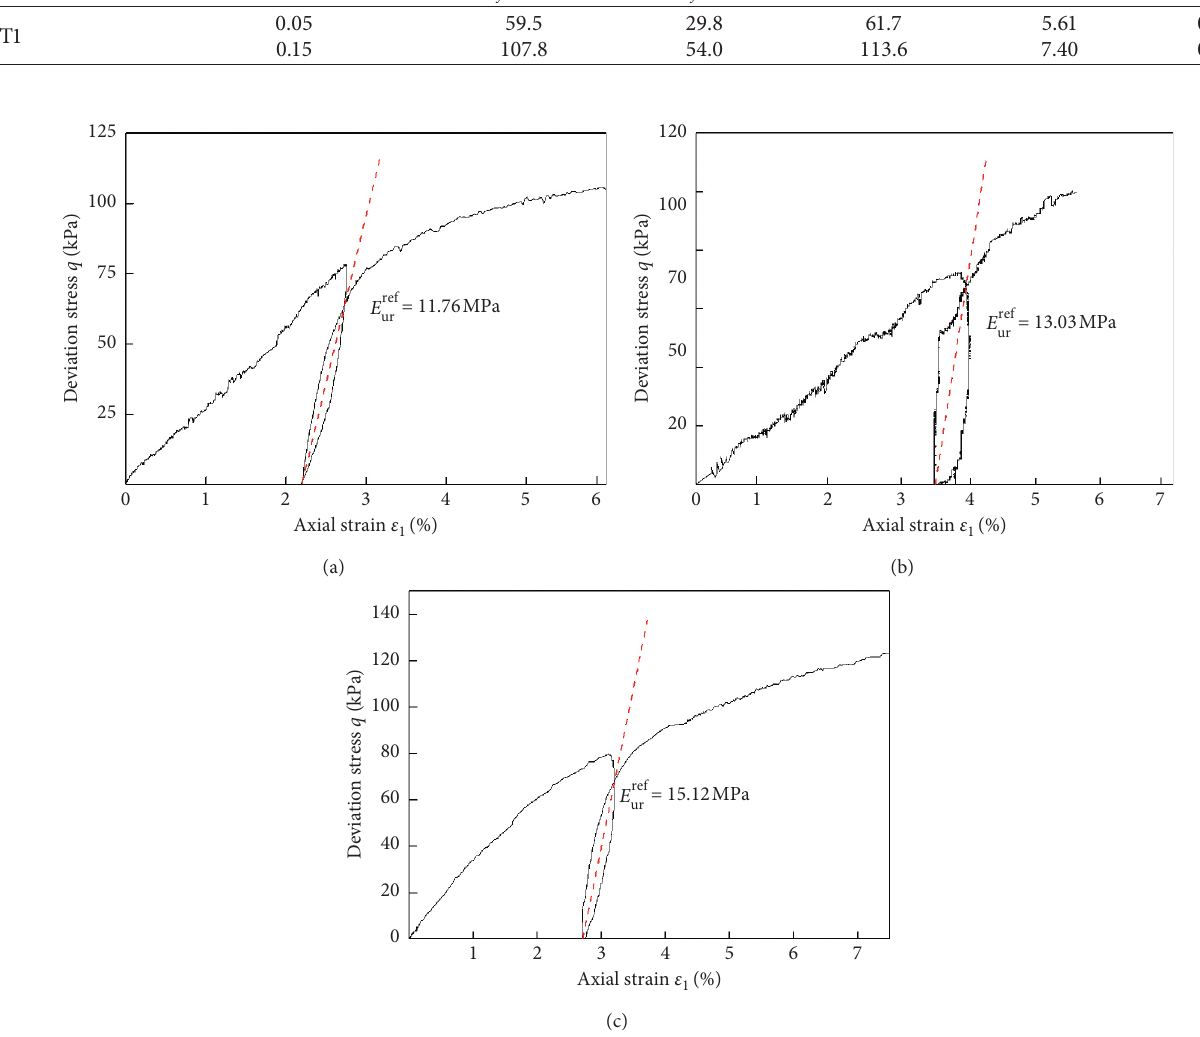
Figure 11: ε ∼ q curves under loading-unloading-reloading under CD tests. (a) T1. (b) T2.